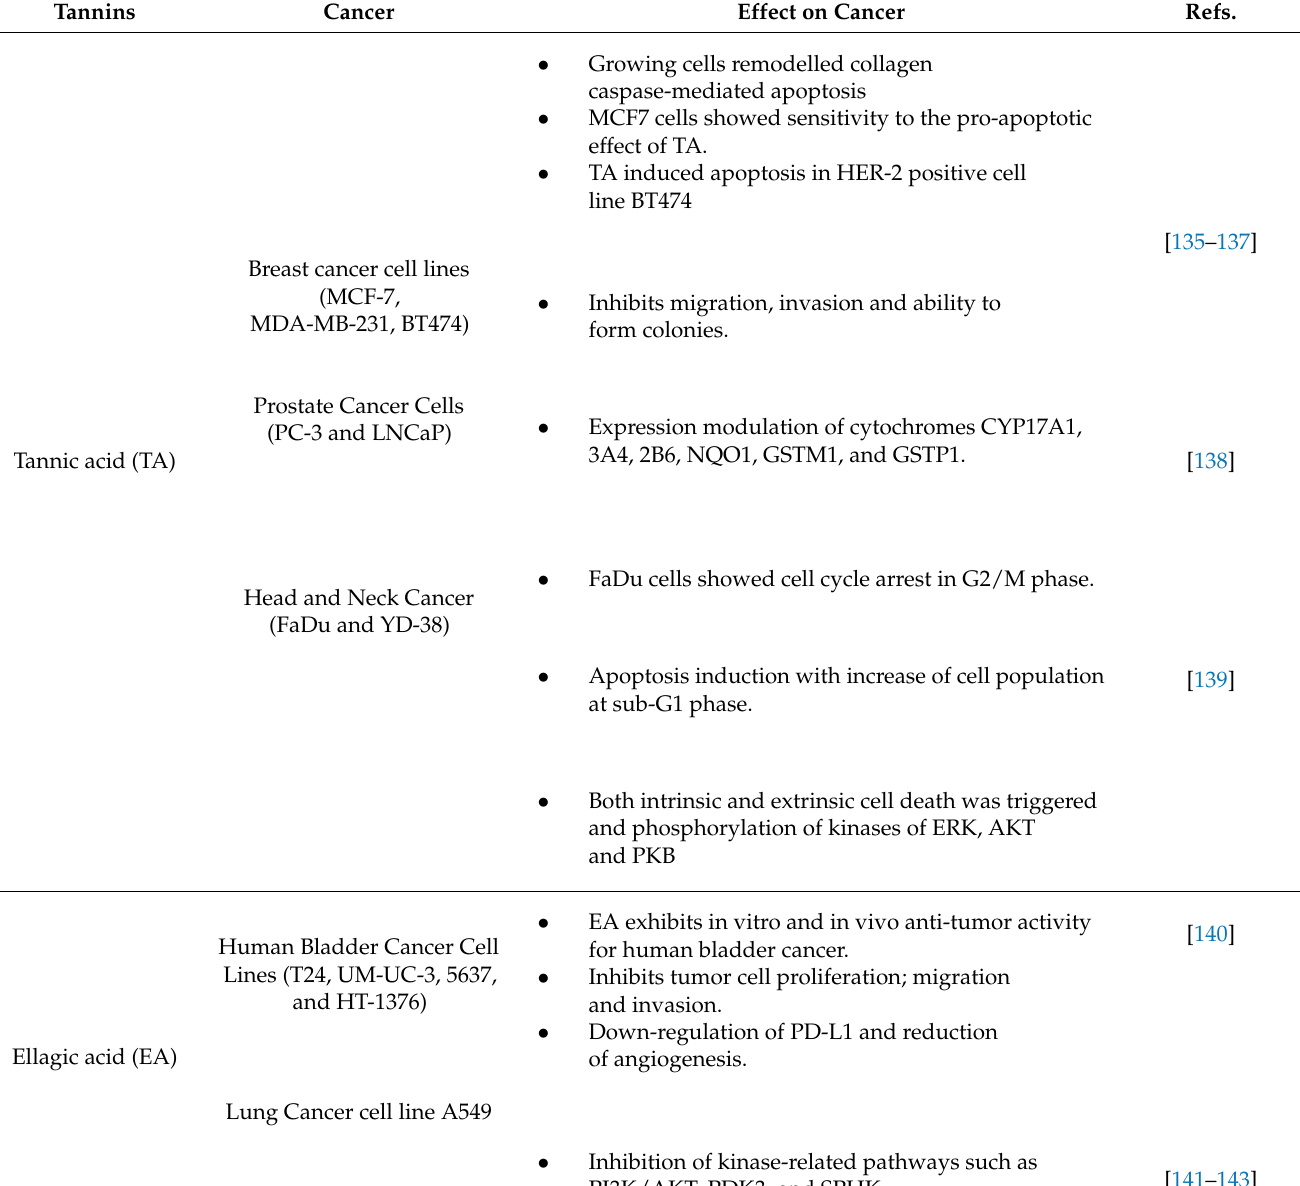
Table 2. Tannins and their roles against cancer proliferation. Tannins Effect on Cancer